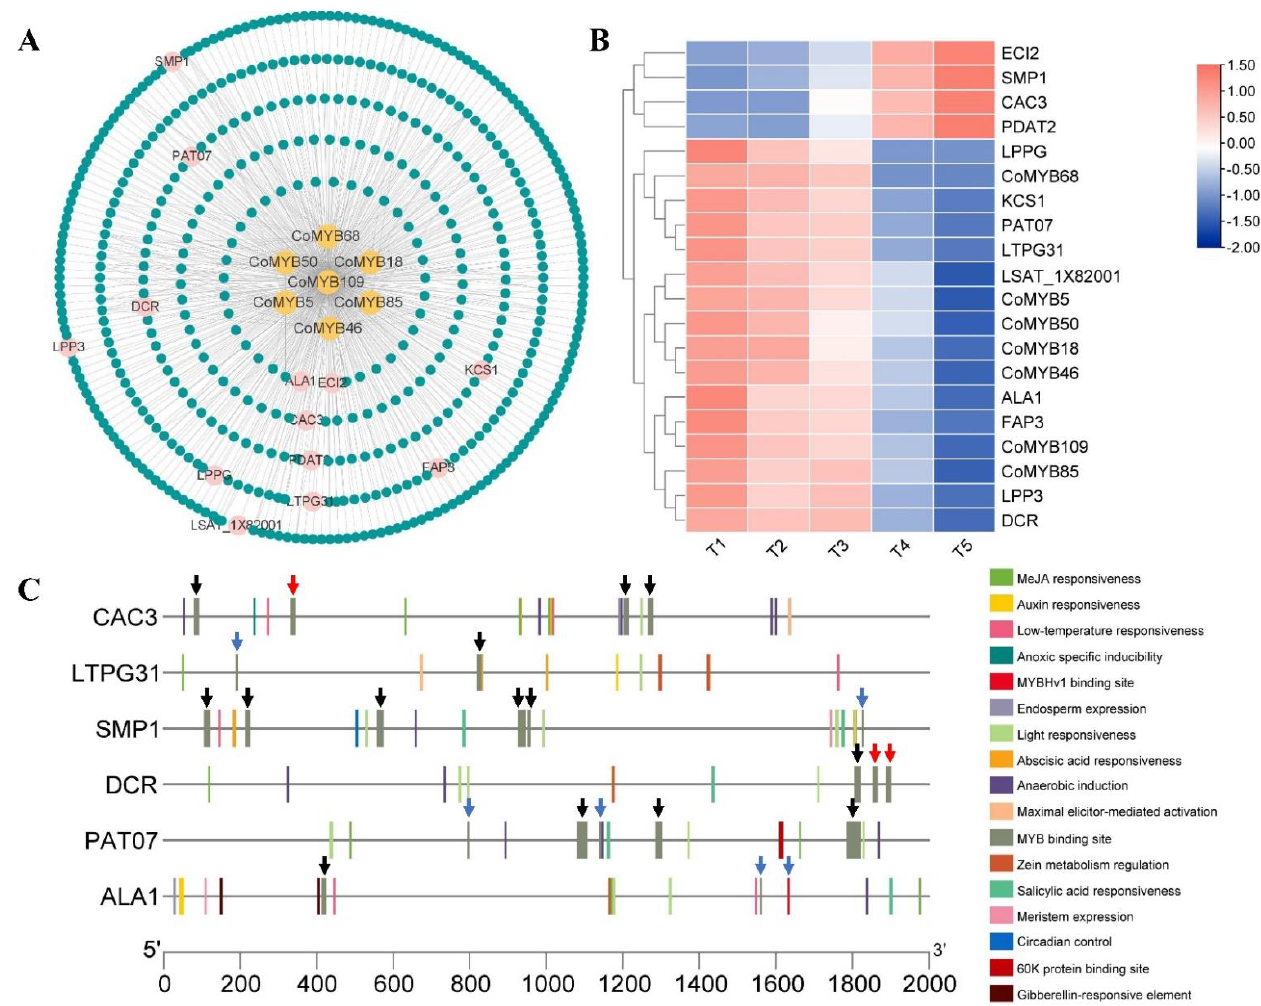
Figure 7. The co-expression network of 7 CoR2R3-MYB genes and expression patterns of 7 CoR2R3-MYB genes and their co-expressed genes related to lipid metabolism or seed maturation. ( A ) The co-expression network of 7 CoR2R3-MYB genes and their co-expression genes. Each dot represents a gene; the orange dots in the innermost circle represent the CoR2R3-MYB genes; the pink dots represent genes associated with seed maturation or lipid metabolism. ( B ) Expression patterns of 7 CoR2R3-MYB genes and their co-expressed genes related to lipid metabolism or seed maturation (homogenize by row). T1 (210 DAP), T2 (235 DAP), T3 (258 DAP), T4 (292 DAP), and T5 (333 DAP) represent five different stages of seed development, respectively. The oil content gradually increased from T1 to T5 and reached the highest at T5. ( C ) Prediction of cis-acting elements in the promoters of lipid metabolism or seed maturation-related genes containing MYB-binding elements. We selected promoters of genes with MYB binding elements in both databases (PlantCARE and Plant Transcription Factor database) for display. The MYB binding elements are indicated by arrows. The black arrow indicates that the element is from the PlantCARE database, the blue arrow indicates that the element is from the Plant Transcription Factor database, and the red arrow indicates that the element exists in both databases.